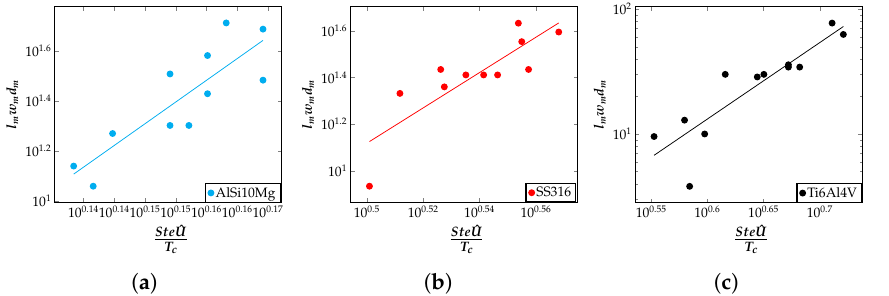
Ste SteE StePe = a + a + a , 0 2 1 T c Tc Tc Tc